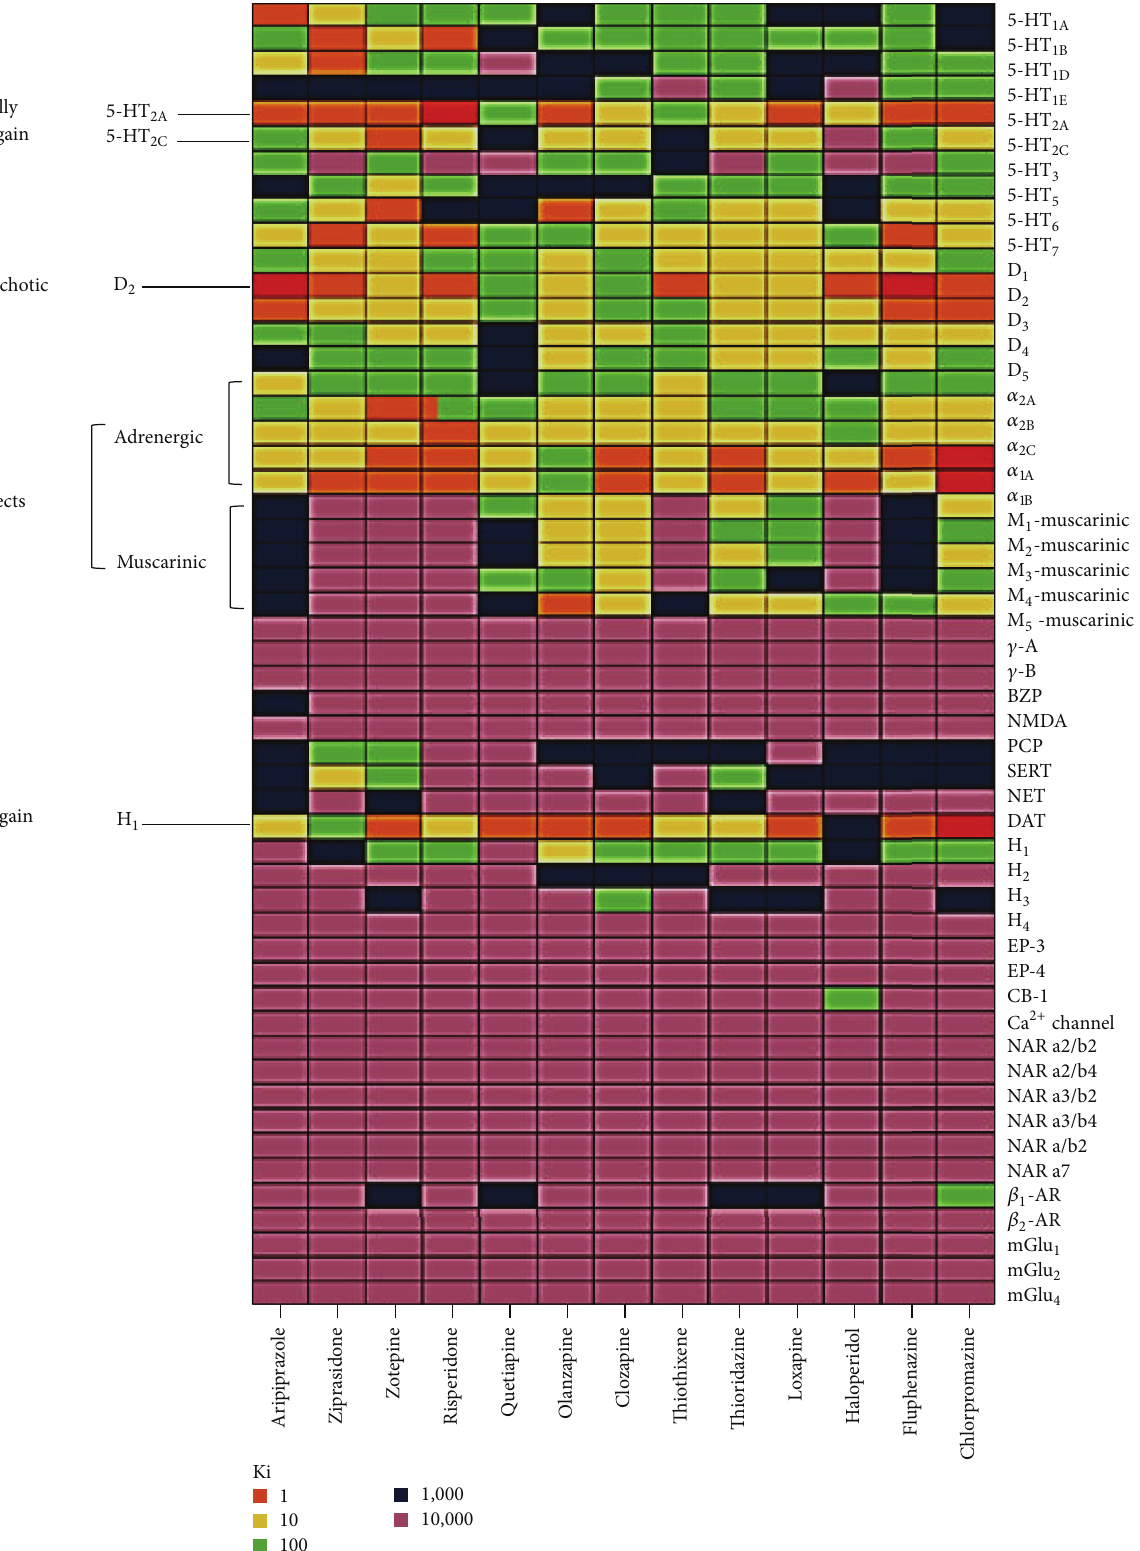
Figure 1: Polypharmacological profiles of antipsychotic drugs. Receptoromic screening identified multiple molecular targets for several antipsychotic drugs. In particulr, clozapine has the high affinity (Ki) to 5-HT serotonin receptors (5-HT2A, 5-HT2C, 5-HT6, and 5-HT7), dopamine receptor (D4), muscarinic receptors, (M1, M2, M3, M4, and M5), adrenergic receptors ( 𝛼 -1 and 𝛼 -2), and other aminergic receptors. Other antipsychotic drugs also interact with multiple targets. More information can be found at NIMH PDSP database (http://pdspdb.unc.edu/pdspWeb/?site=kidb) (reprinted with permission from Nature Publishing